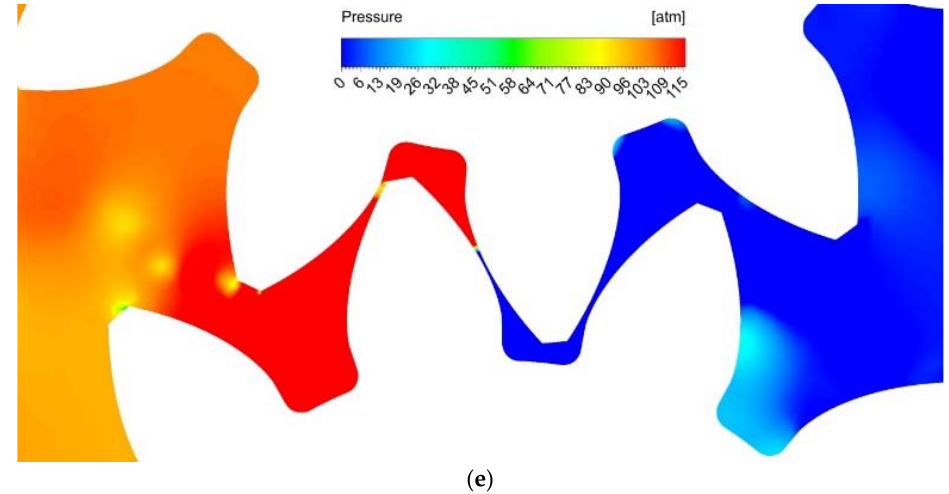
Figure 13. Pressure distribution for a fuel pump (( a – e ) in accordance with the position in Figure 10)